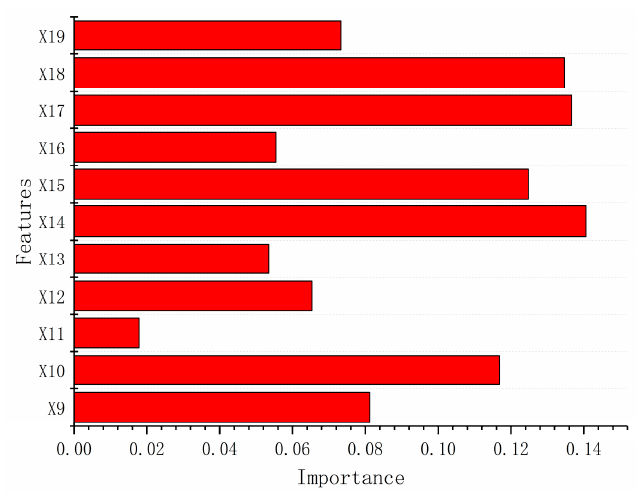
Figure 10. The importance of the features of the steam consumption model.